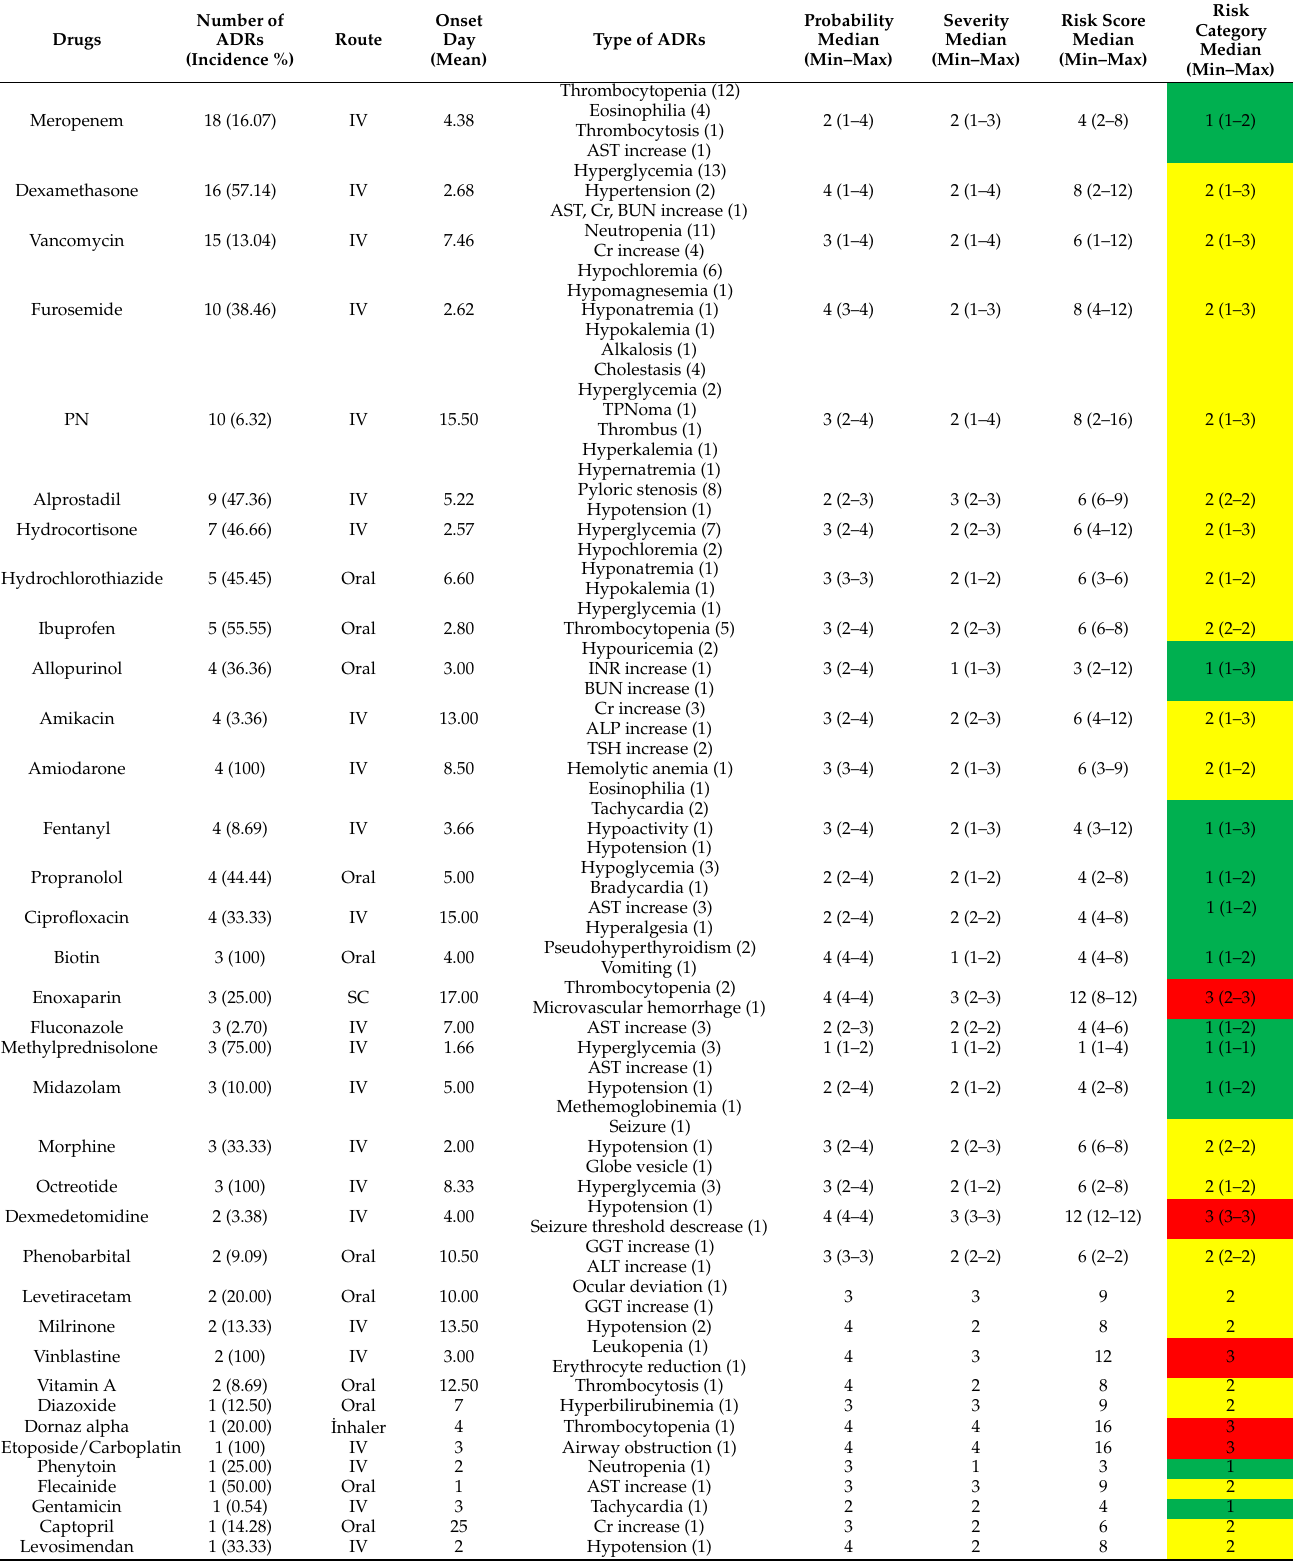
Table 1. The route of administration, onset day, type of ADRs, probability, severity, risk score, and risk category of the drugs ( n =